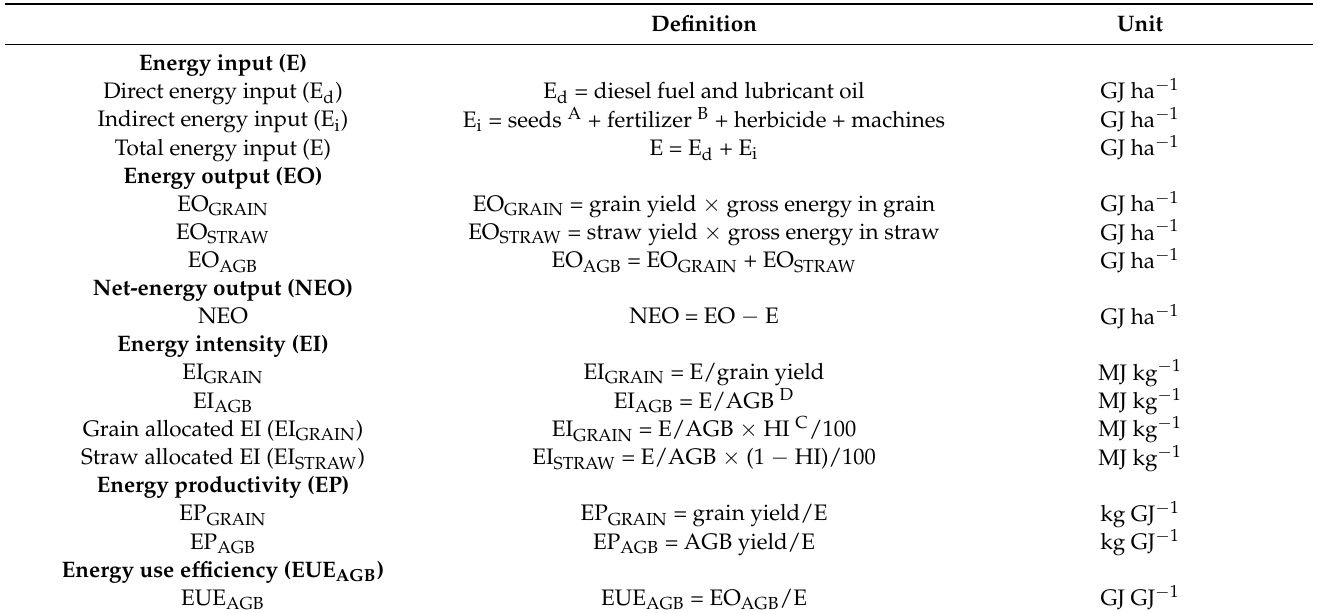
Table 3. Definition of energy efficiency